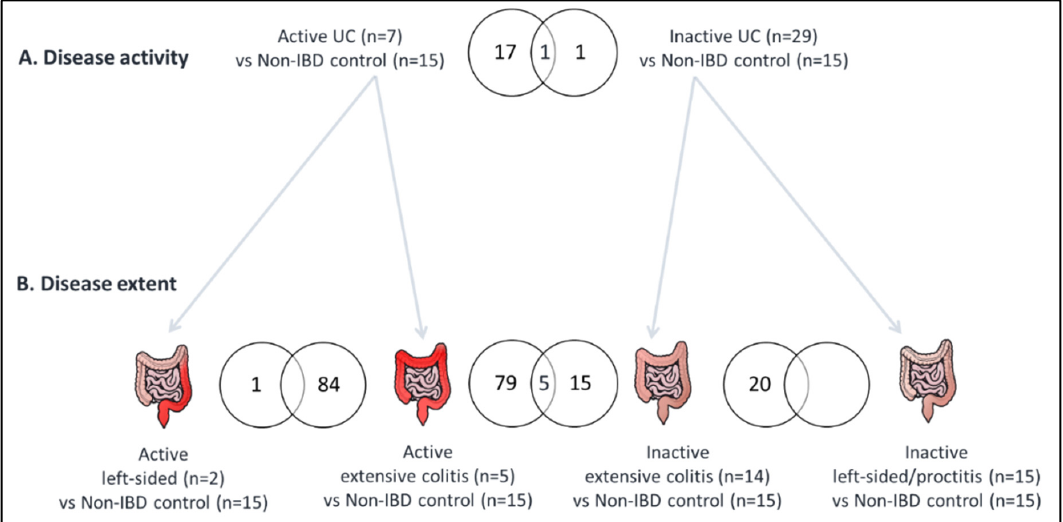
Figure 1. Overview of significantly dysregulated genes in the different comparisons. Venn diagrams of the differentially expressed genes in the comparative analysis of ( A ) active or inactive ulcerative colitis (UC) patients and non- inflammatory bowel disease (IBD) controls; and of ( B ) Extensive UC or left-sided colitis/proctitis and non-IBD controls, in active and inactive UC separately. The number of significantly differentially expressed genes in each comparative analysis is shown in circles. The number of overlapping genes between comparisons is also indicated.